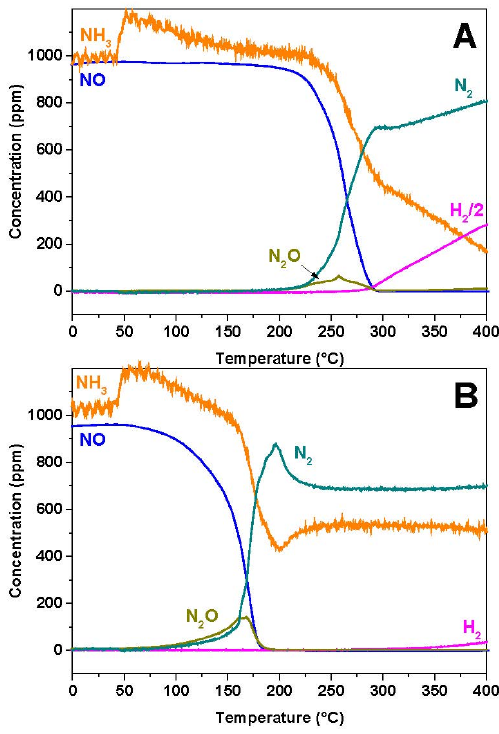
Figure 5. NO/NH 3 ‐ TPR experiments with NO (1000 ppm) + NH 3 (1000 ppm) over ( A ) Rh ‐ BaO/Al 2 O 3 and ( B ) Pt ‐ BaO/Al 2 O 3 from 40–400 °C (4 °C/min) (rig#3). and ( B ) Pt-BaO/Al ˝ C (4 ˝ C/min) 2 O 3 from 40–400